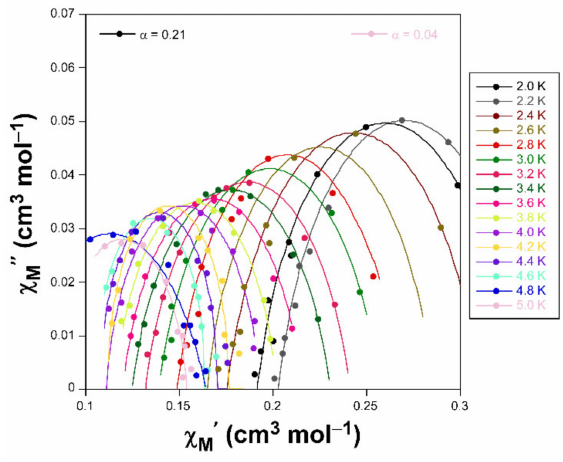
Figure 4. Cole-Cole plots in the form of χ M ” vs χ M ’ for compound 1 under an applied field of 1